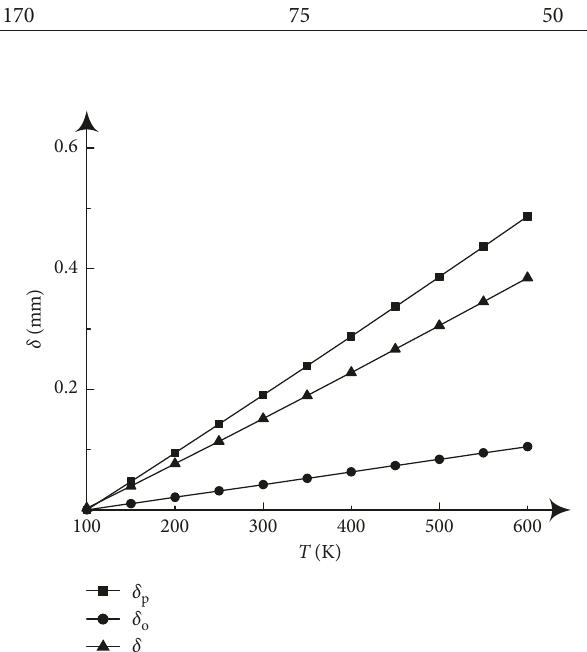
Figure 4: Change of fit clearance with